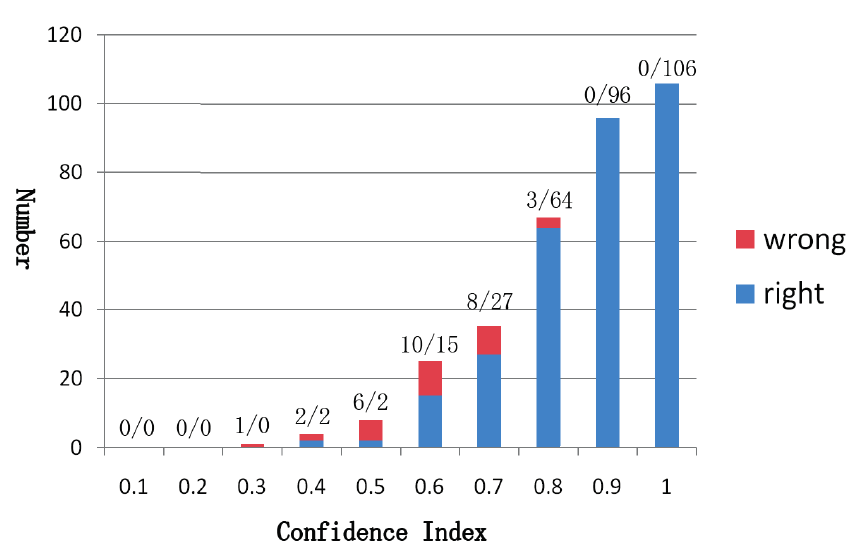
Figure 10. The confidence index with numbers of right and wrong detections, where 0.1 represents the range of 0 to 0.1, 0.2 represents the range of 0.1 to 0.2, etc. For the number 8/27, 8 represents the number of wrong detections in the range of 0.6 to 0.7 and 27 represents the number of right detections in the range of 0.6 to